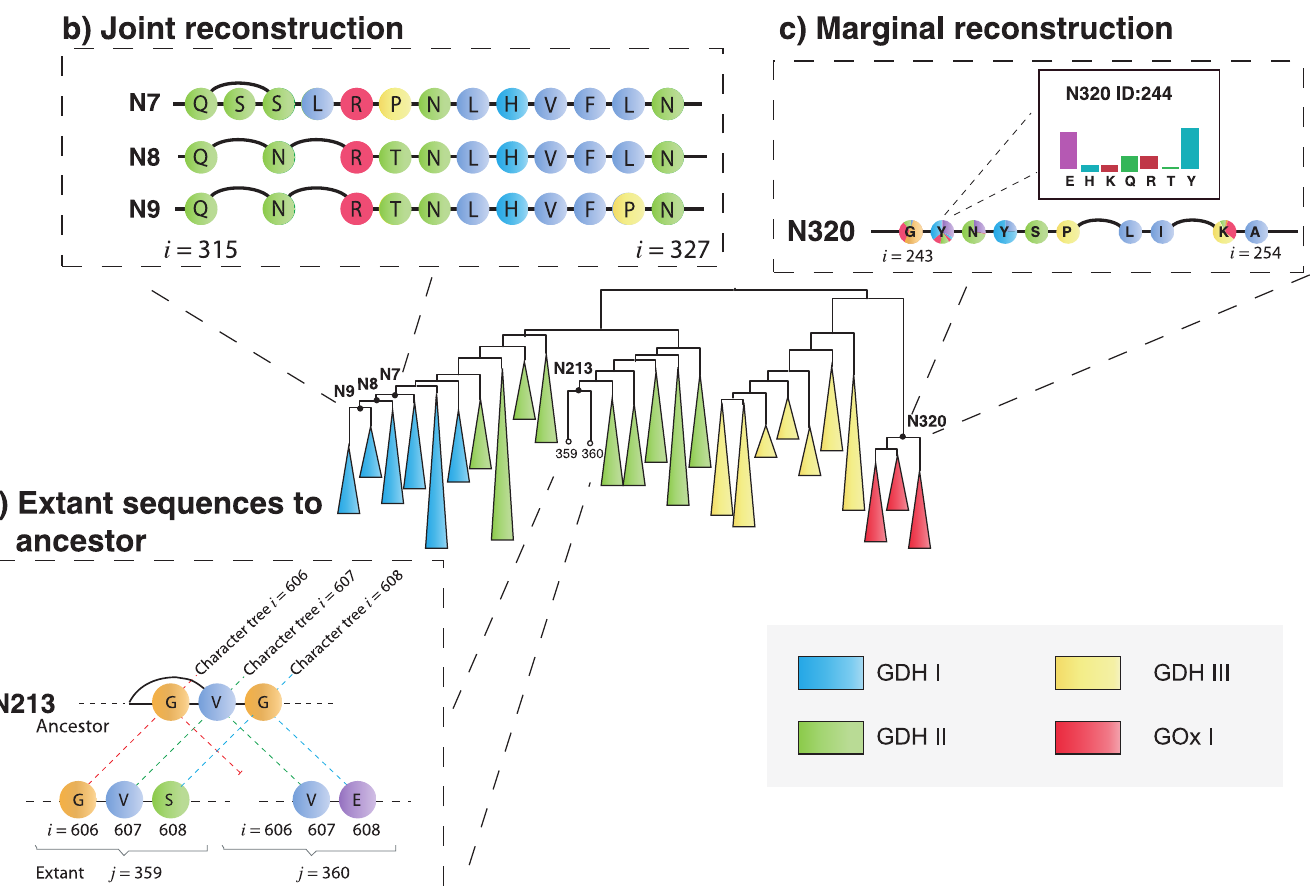
Fig 1. Phylogenetic tree showing a reconstruction of fungal GDH and GOx sequences decorated with illustrations of key concepts used within GRASP. A , Two extant POGs ( j indicates extant sequence number) mapped to an ancestral POG. Each extant POG has a single path through strictly ordered sequence positions ( i indicates position). Ancestral states are influenced by all sequences, which explains why i = 608 is inferred as glycine, despite glycine not appearing in either sequence j = 359 or 360. B , Three ancestor POGs showing most probable assignments from a joint reconstruction at positions i 2 {315, ... , 327} for nodes N7, N8, and N9. GRASP supports the simultaneous viewing of multiple ancestors from a joint reconstruction, enabling a direct comparison at different time points. C , A single ancestor POG showing inferred marginal distributions at positions i 2 {243, ... , 254} for node N320. For marginal reconstructions, nodes are coloured according to their posterior probabilities and can be queried to view histograms of these underlying distributions, as is done for position i = 244. The marginal reconstruction from (c) was used to reconstruct the inferred ancestor (N320) as well as an alternative ancestor in which a single amino acid (N320_Y244E) was altered based on posterior probabilities from the marginal distribution that resulted in increased thermal stability (S1